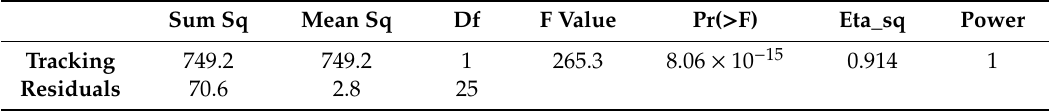
Table 3. Type III unbalanced design ANOVA for Duration of Run for Males.